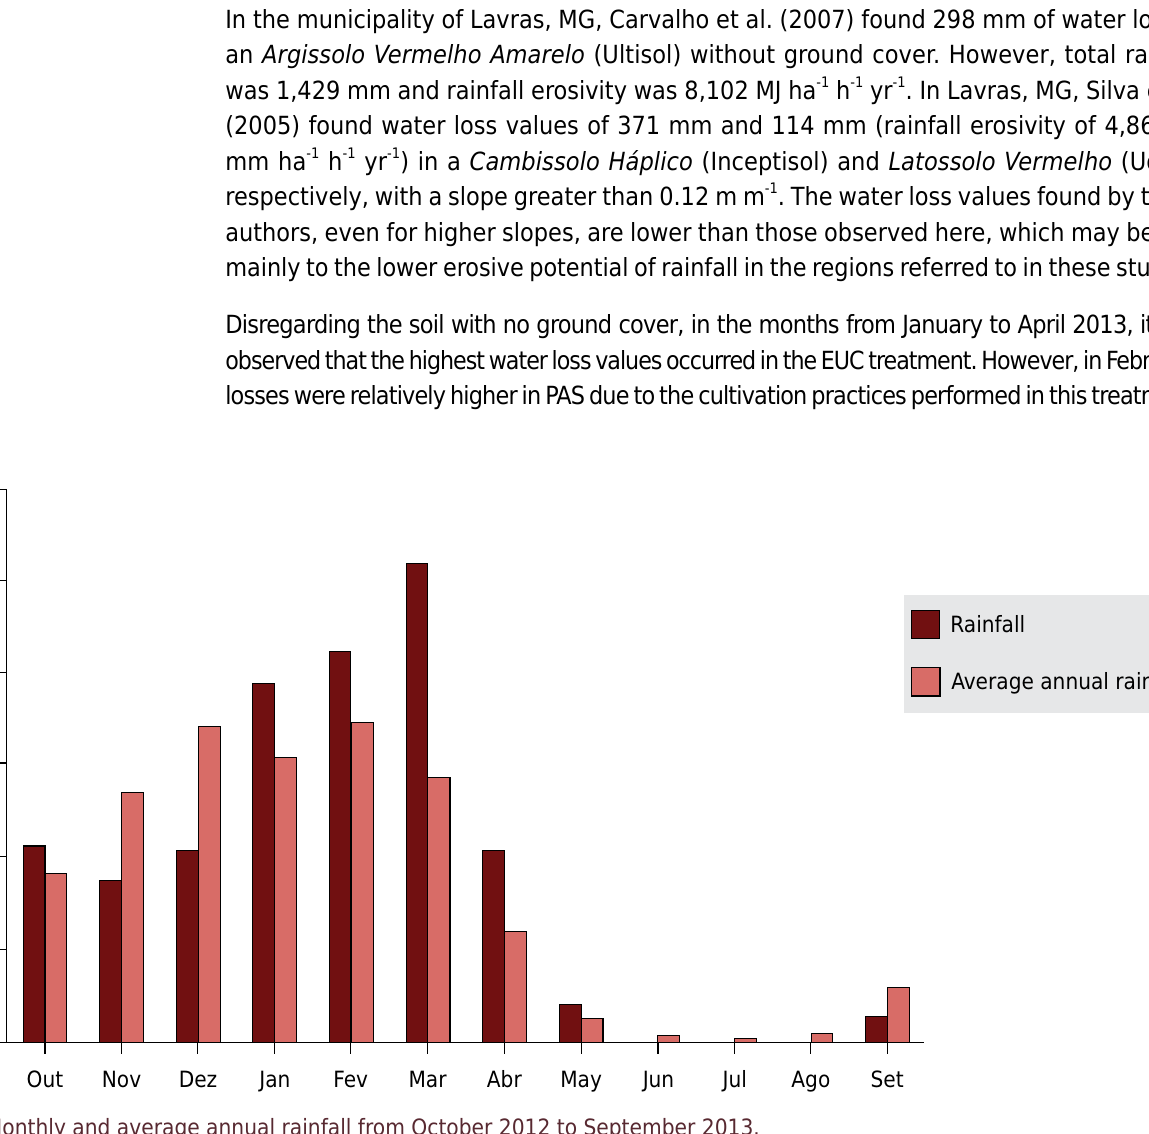
Figure 2. Monthly and average annual rainfall from October 2012 to September